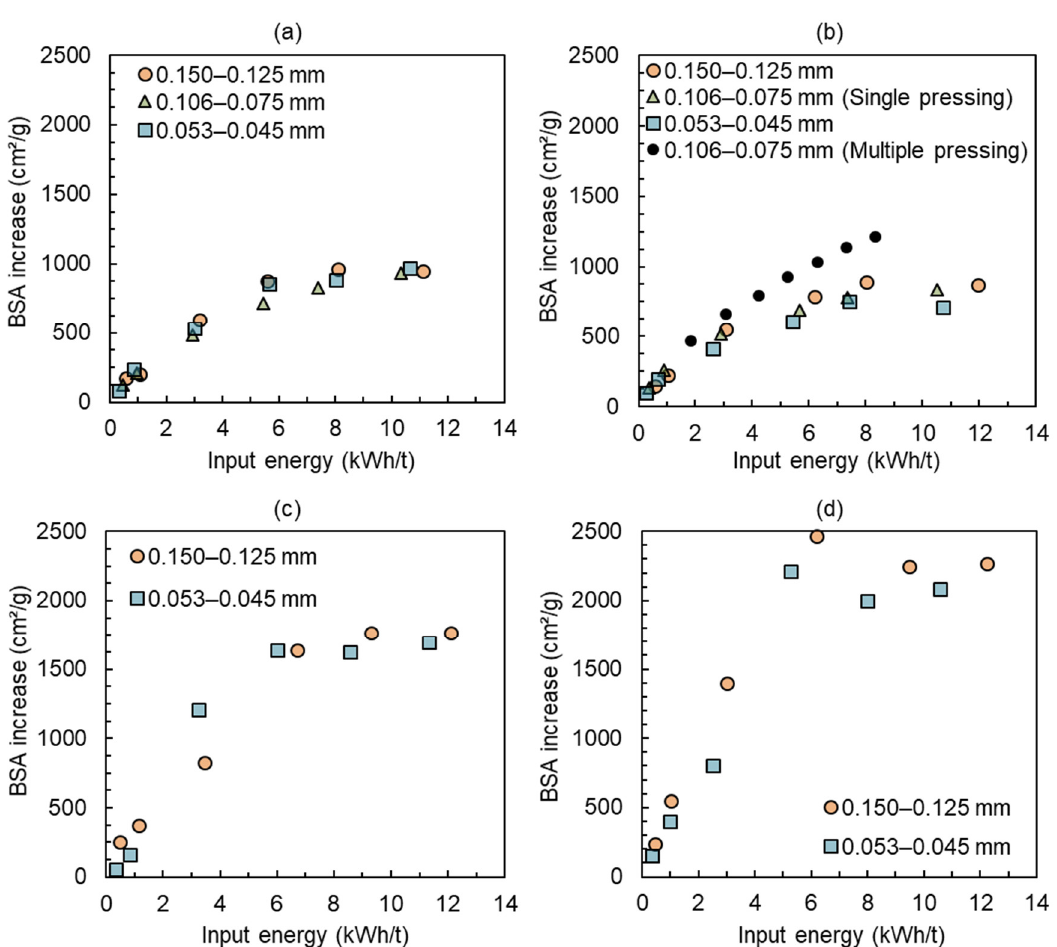
Figure 9. Relationship between Blaine specific surface area (BSA) increase and specific input energy ( a ) Brucutu, ( b ) Itabira, ( c ) Timbopeba, and ( d ) Caraj á s for ( a ) Brucutu, ( b ) Itabira, ( c ) Timbopeba, and ( d ) Carajás samples.